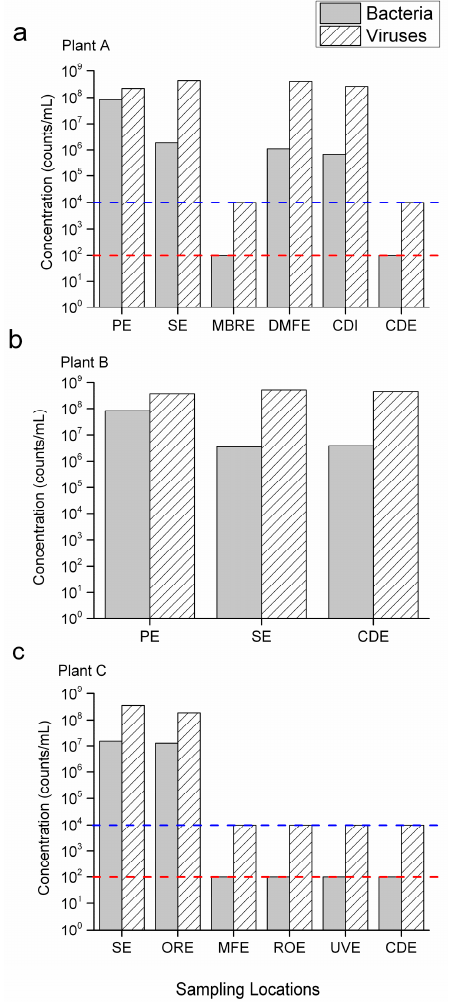
Figure 3. Bacterial and viral counts by FCM in wastewater effluent treated by different engineering processes from three Southern California water reclamation plants (Plant A, B and C) (relative standard deviation <5% for each bar graph). PE: primary effluent; SE: secondary effluent; MBRE: membrane bioreactor effluent; DMFE: dual medium filtration effluent; CDI: chlorine disinfection influent; CDE: chlorine disinfection effluent; ORE: Ozone reactor effluent; MFE: microfiltration effluent; ROE: reverse osmosis effluent; UVE: UV treatment effluent. The red line and blue line indicate the FCM detection limits of bacteria and virus under current assay conditions, respectively.